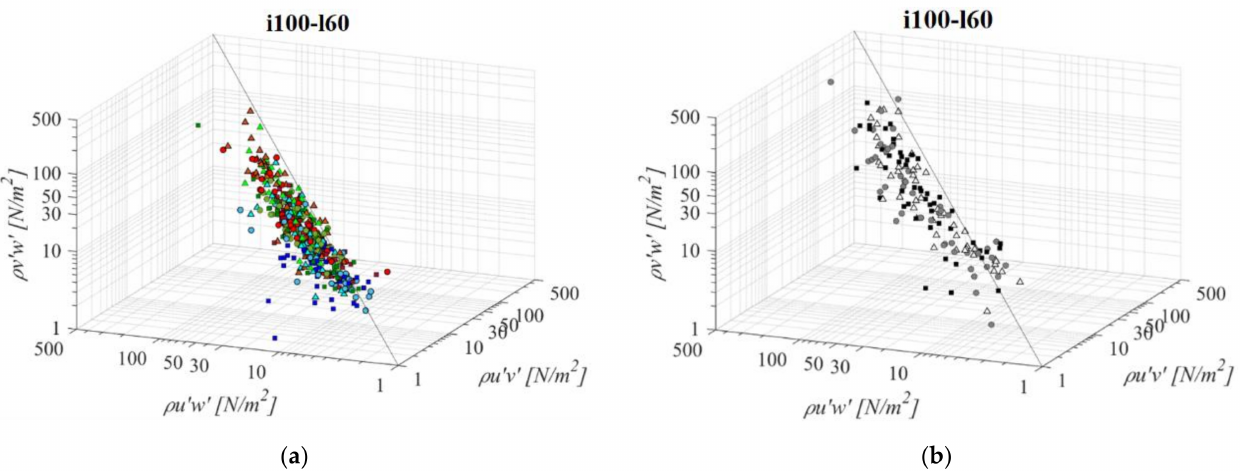
Figure 9. 3D scatterplot of concurrent RSS components for the i100l60 fishway configuration: ( a ) pool-orifice type fishway and ( b ) vertical slot fishway.